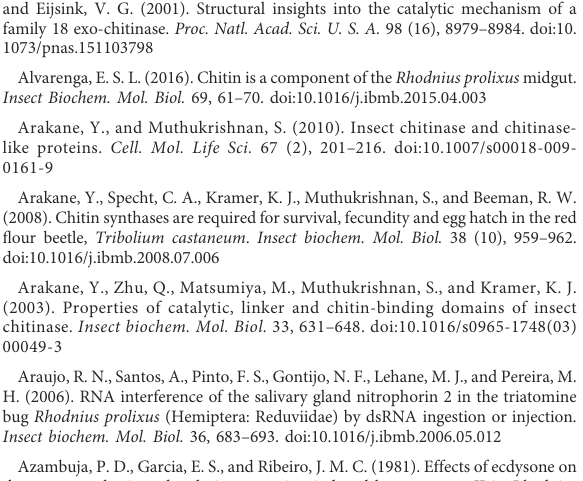
SUPPLEMENTARY TABLE S1 Oligonucleotide primers sequences used for semi-quantitative RT-PCR and synthesis of dsRNA of transcripts encoding the GH18 family in R. prolixus and Actin, the constitutive gene used. For the synthesis of dsRNA, each speci fi c sequence was coupled to the T7 promoter sequence (23bp) according to manufacturer instructions (RiboMAX express T7 RNAi system, Promega, USA). Forward: Sense initiator. Reverse: Antisense initiator. Bp: base pairs.